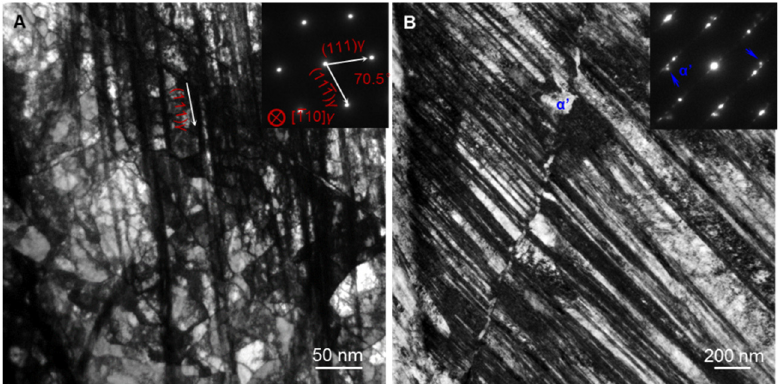
Figure 5. Bright-field TEM images of deformation microstructure of the GDS 304 SS at a tensile strain of 40%, showing the refined dislocation structure ( A ) and the formation of deformation nanotwin and α ’-martensite phase ( B